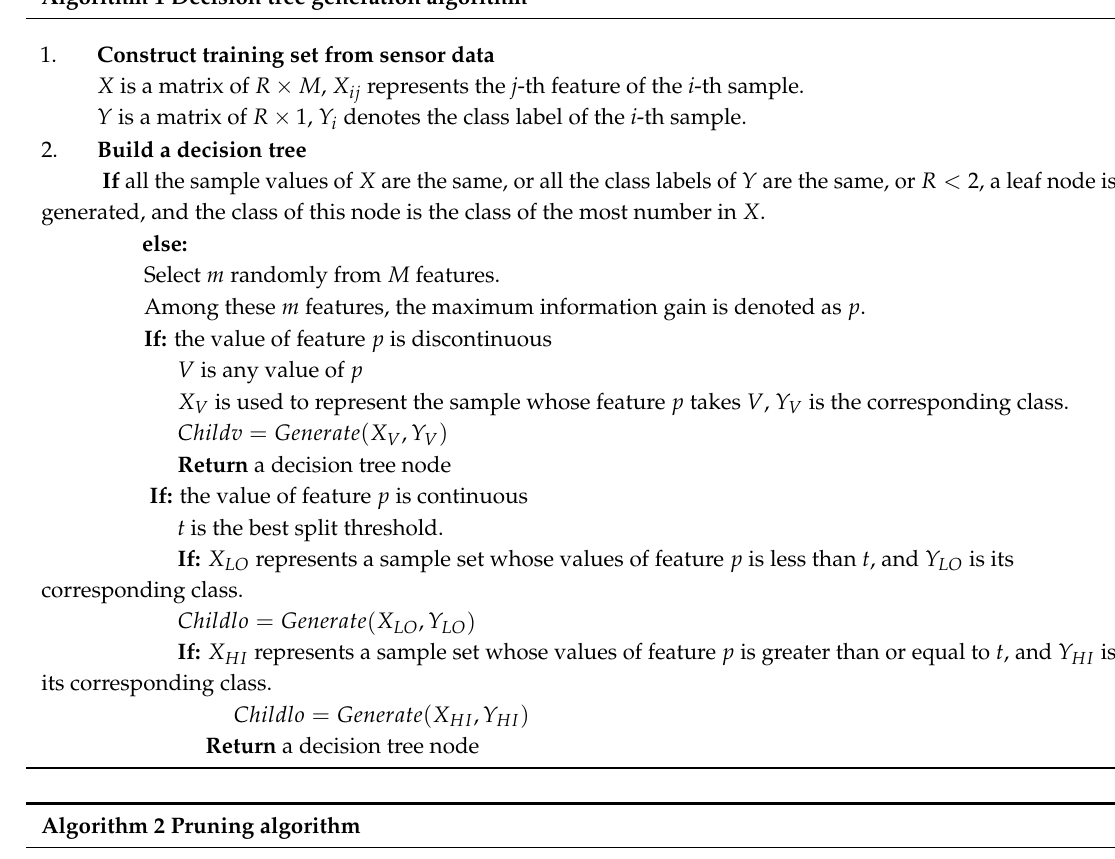
Algorithm 1 Decision tree generation algorithm